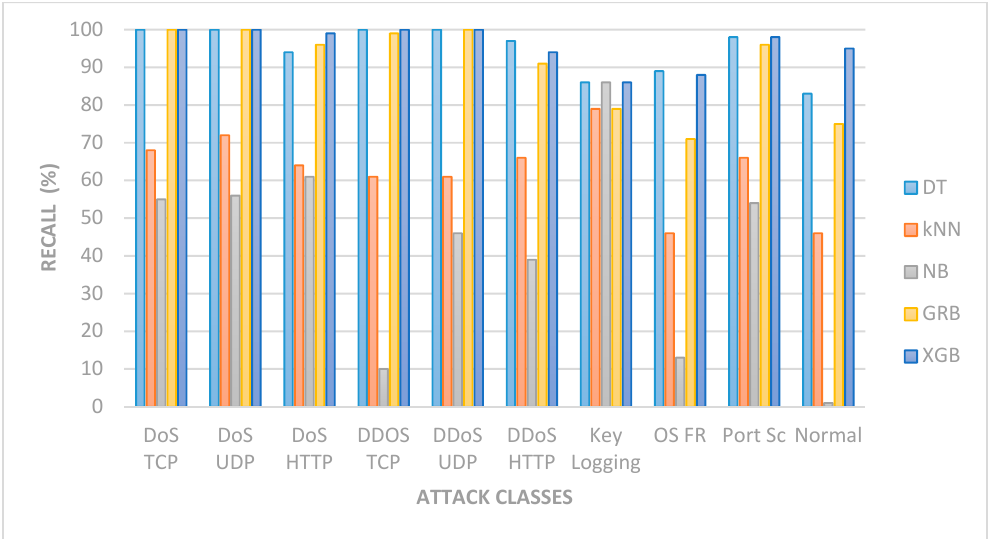
Figure 12. Recall of multiclass classification Instances.